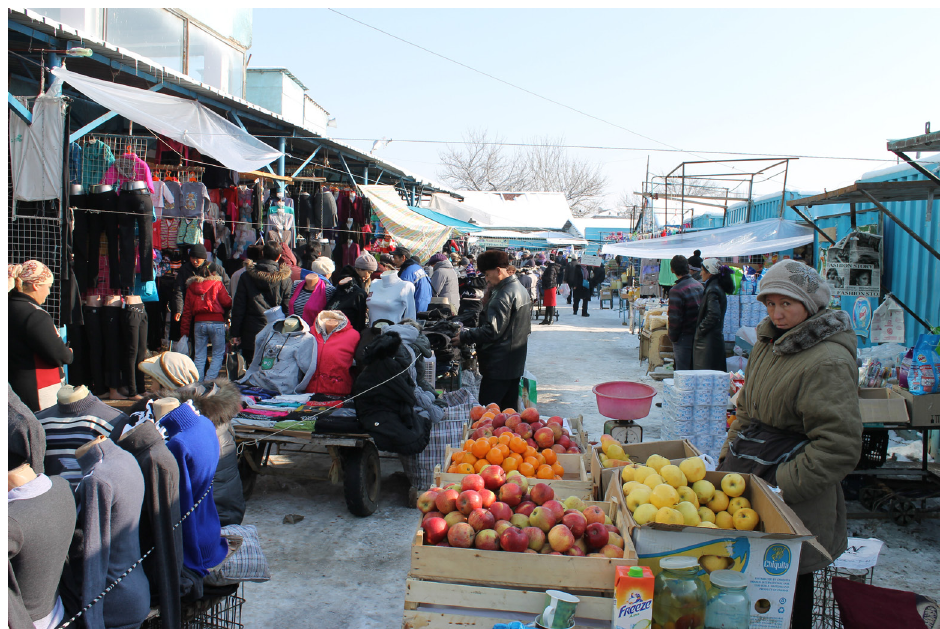
Fig. 2: The excavation at Taraz city was located in the bustling heart of the central